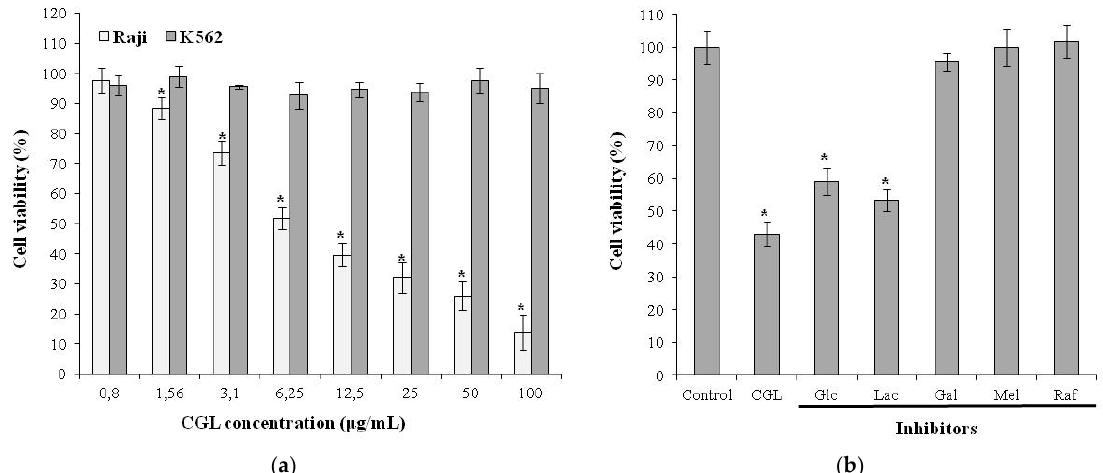
Figure 6. ( a ) Cytotoxic effect of CGL on Raji and K562 cells. ( b ) Inhibition of cytotoxic effect of CGL on Raji cells by addition of various saccharides: Control—only cells with culture medium; CGL—lectin (10 µg/mL) with cells, no inhibitor; Glc— D -glucose; Mel – melibiose; Raf—raffinose; Gal—D-galactose; Lac—lactose. The data are expressed as mean ± SD of three separate experiments. * indicates a significant di ff erence at the level of p < 0.05. Figure was modified from